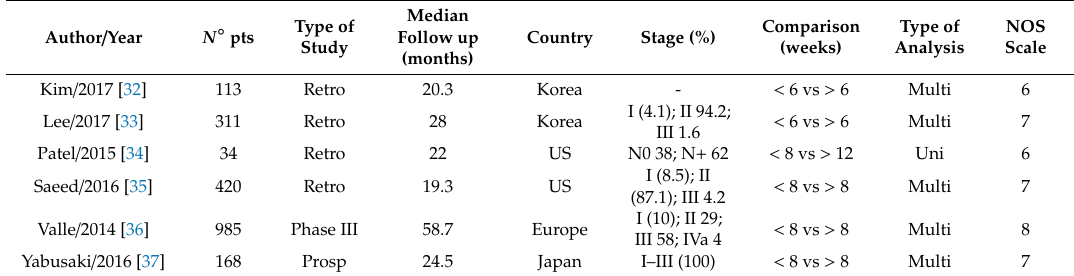
Table 3. Characteristics of included studies for pancreatic